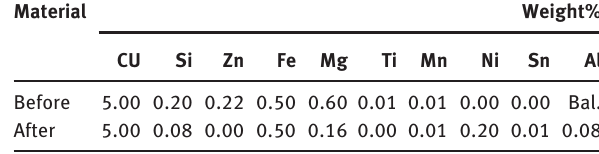
Table 1 Chemical compositions of Al-Cu before and after addition of TiO . 2